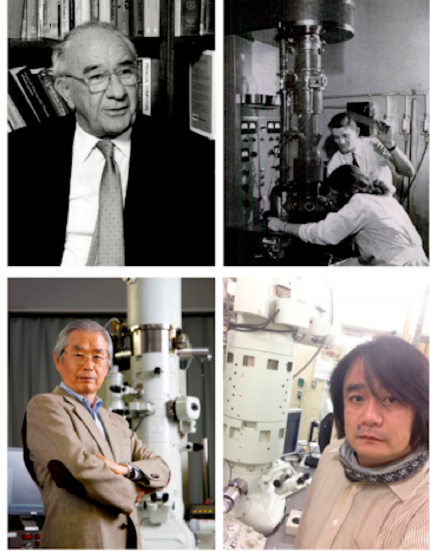
Figure 14. Some of the pioneers of the study of carbon by TEM. Clockwise from top left: Trevor Evans, Robert Heidenreich, Kazu Suenaga, and Sumio Iijima.